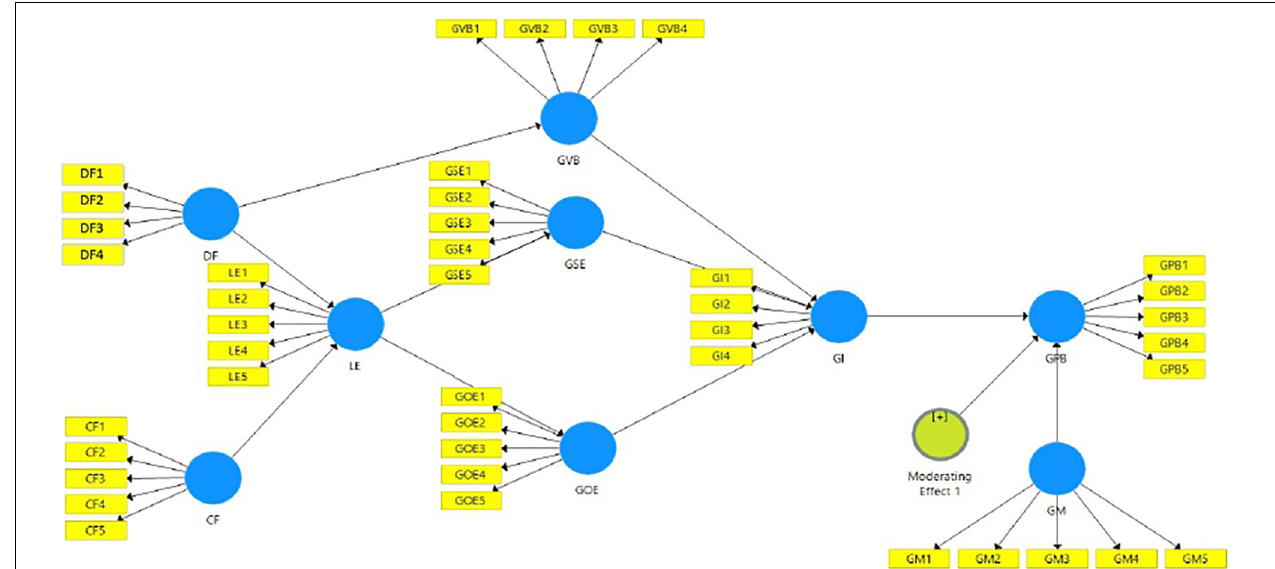
FIGURE 2 | Path diagram of conceptual